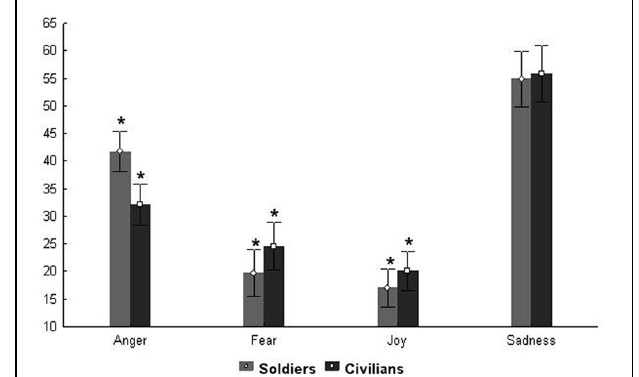
FIGURE 4 | Errors total Percentage. Plots show the number of incorrect uses of each emotion label as a percentage (indicated in Y axis) of the total errors made by each subject of both groups of participants. ∗ Ps < 0 .